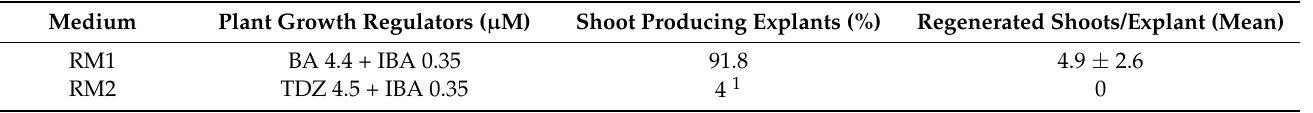
Table 1. Effects of plant growth regulators on the morphogenetic response of leaf disc explants of Artemisia annua . Values are expressed as percentages (%) or means ± SD (n = 50, two independent experiments).